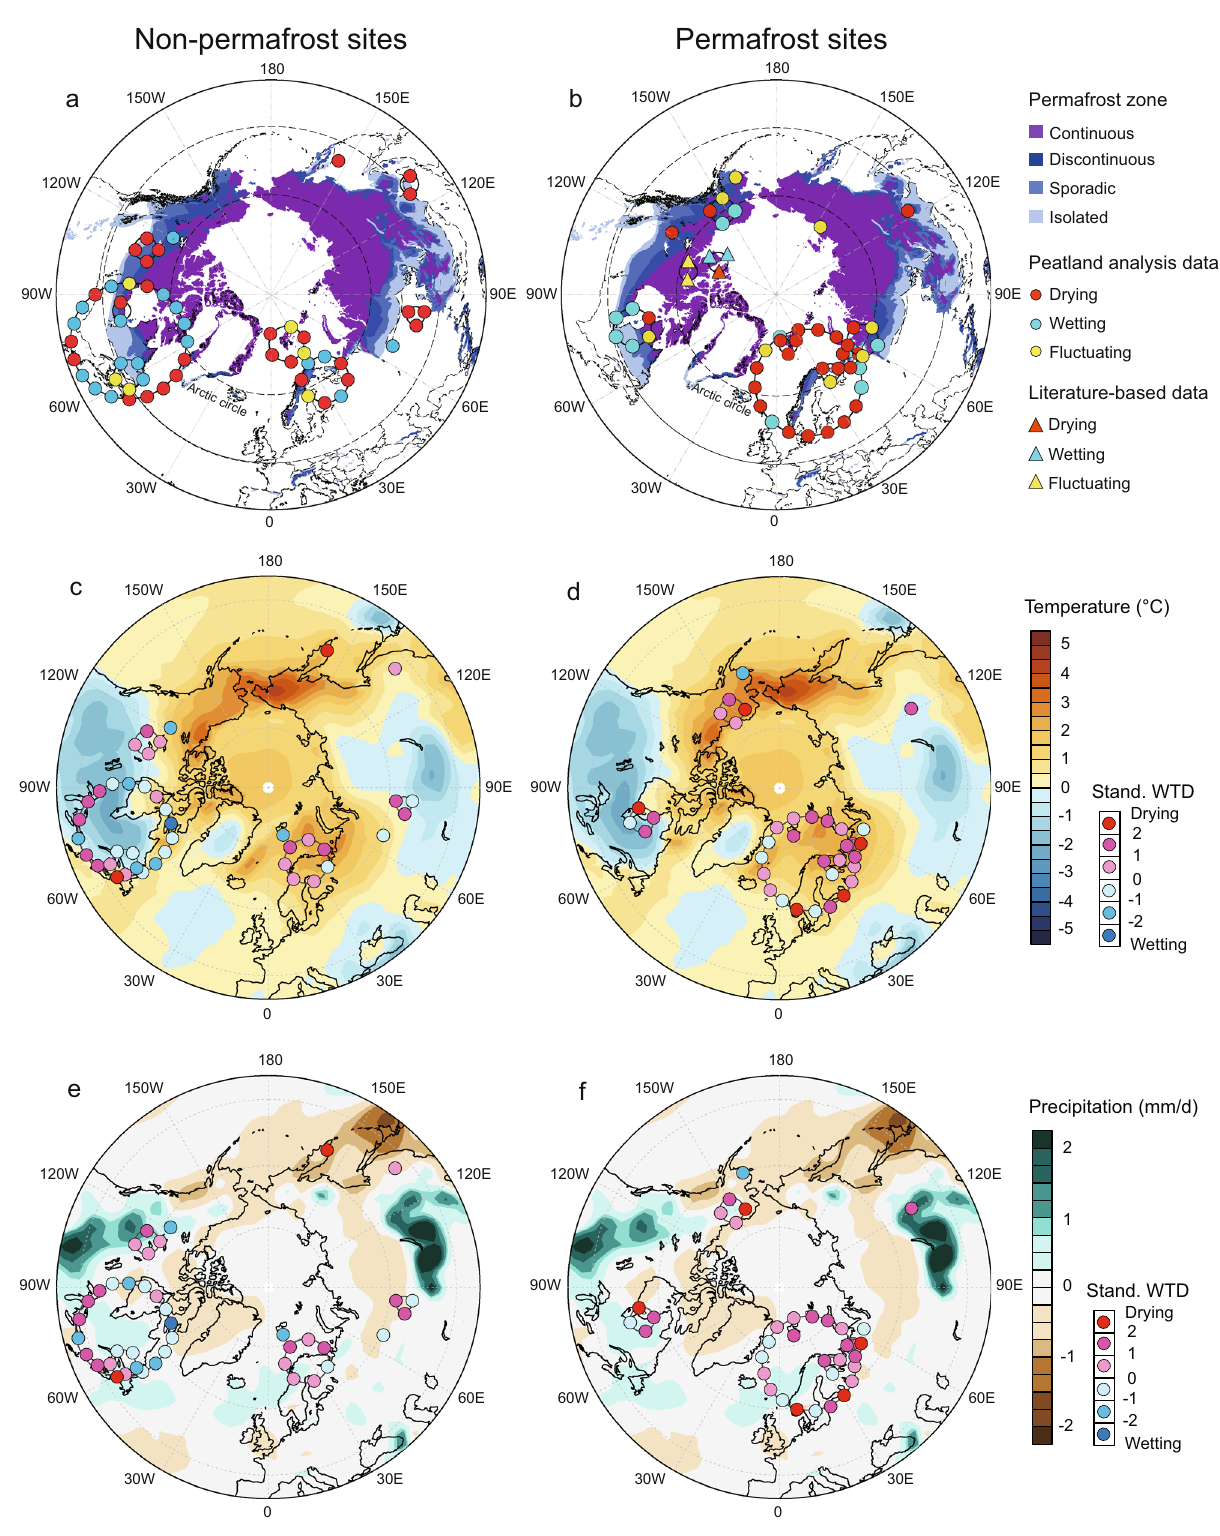
Fig.1|Studysitesandtheirhydrologicalresponses. Non-permafrost( a , c , e )and permafrost ( b , d , f ) sites are plotted separately. a , b Reconstructed hydrological response of 98 records since 1600 CE on the map of northern permafrost zones 35 . Literature-based fi ve records are indicated by triangle symbol. c , d Reconstructed standardised water-table depths (WTDs) on the map of summer (June-July-August) temperature anomaly (°C). e , f Reconstructed WTDs on the map of summer pre- cipitationanomaly(mm/day).WTDs,temperatureandprecipitationdatapresented